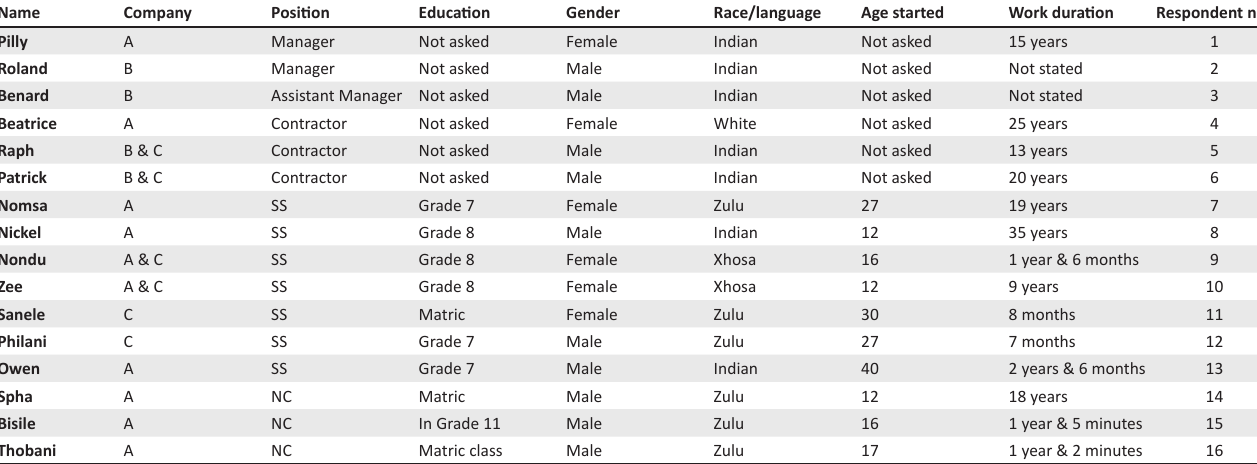
TABLE 1: General information on research respondents. a